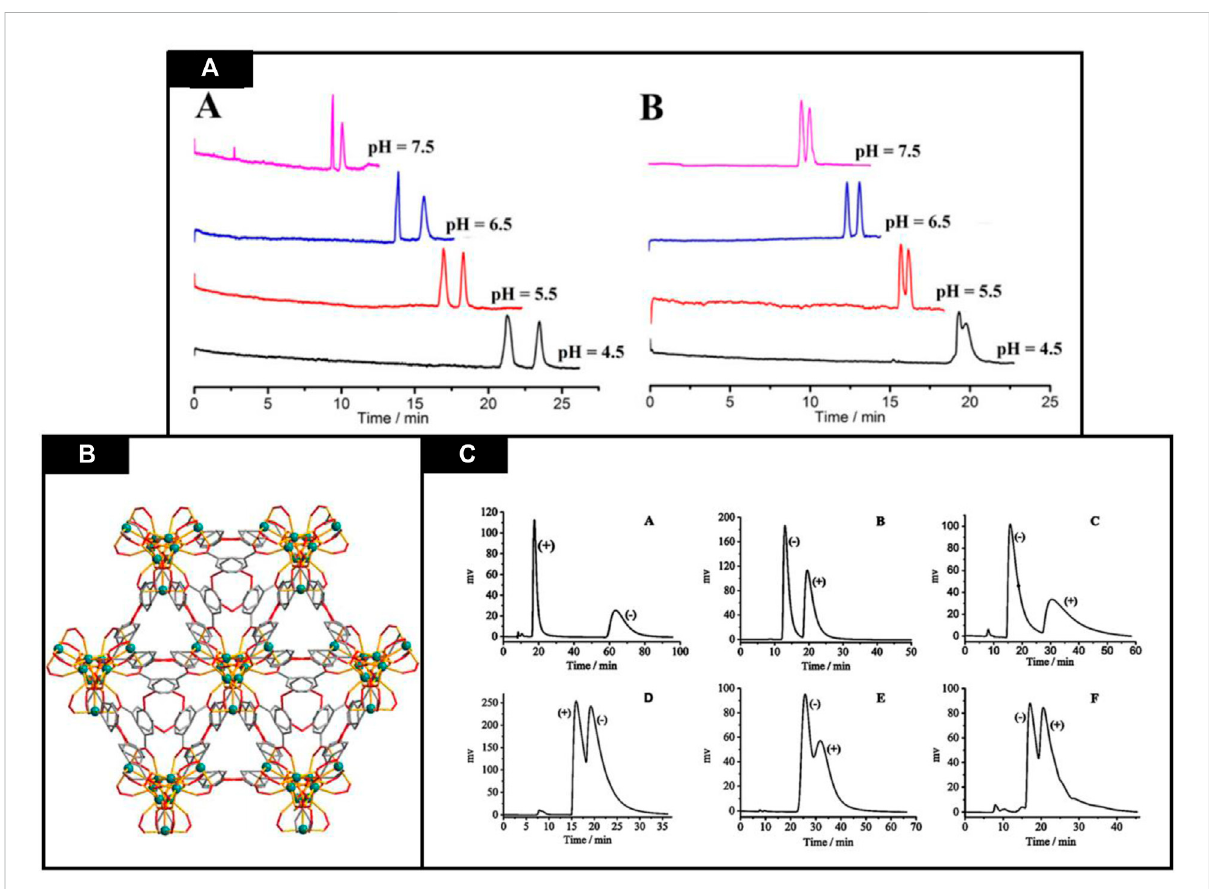
FIGURE 7 (A) Buffer pH effect on fl avanone separation (A) and praziquantel (B) . Reproduced with permission from (Grancha et al., 2017) (B) [In 3 O(obb) 3 (HCO 2 )(H 2 O)] solvent 3D structure (O — red In — green,C – gray) Reproduced with permission from (Jeong et al., 2011) (C) Racemates separation through Cd-MOF column ’ using HPLC. (A) 1-(1-naphthyl)ethanol, (B) 1,1 ′ -bi-2-naphthol, (C) 1-(4-chlorophenyl)ethanol, (D) benzoin,